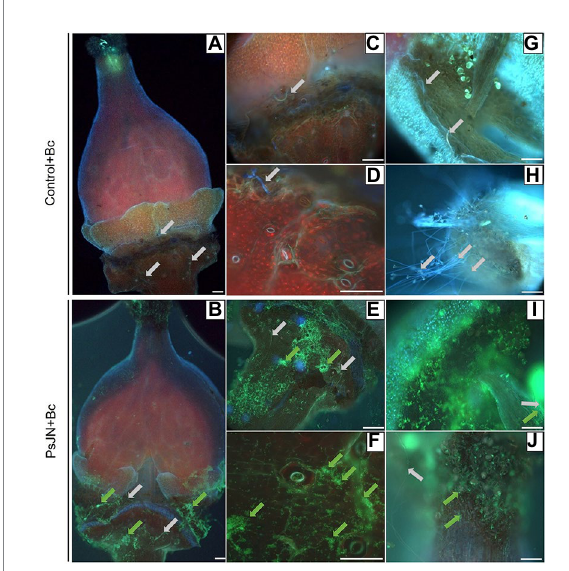
FIGURE 9 Botrytis cinerea development and Paraburkholderia phytofirmans - gfp localization on grapevine inflorescences. The inflorescences were sprayed with PsJN- gfp (10 8 CFU ml − 1 ) or with PBS as control. Twenty-four hours after, B. cinerea was sprayed (1 ml of a 10 3 conidia ml − 1 ). Microscopic observations were realized 72 hpi by the fungus on flowers (A,B) , receptacle (C–E) , stomata (D–F) , stamen (G–I) and stigmate (H–J) . Scale bars = 100 μ m. Green arrows: PsJN- gfp , grey arrows: B.